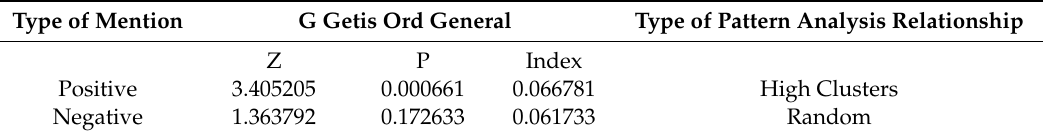
Table 8. G Getis Ord test on Comfort.